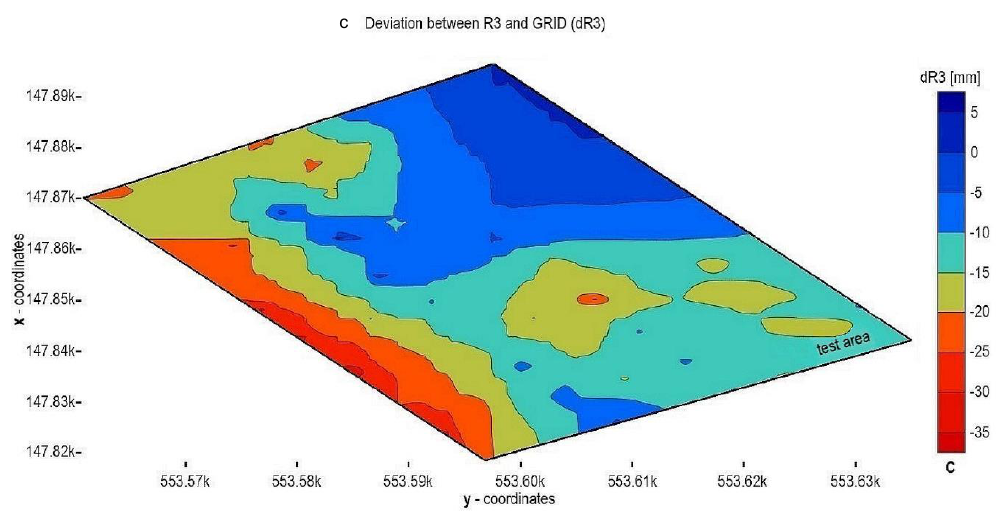
Figure 7. Results of monitoring in the information diagram of the decision support